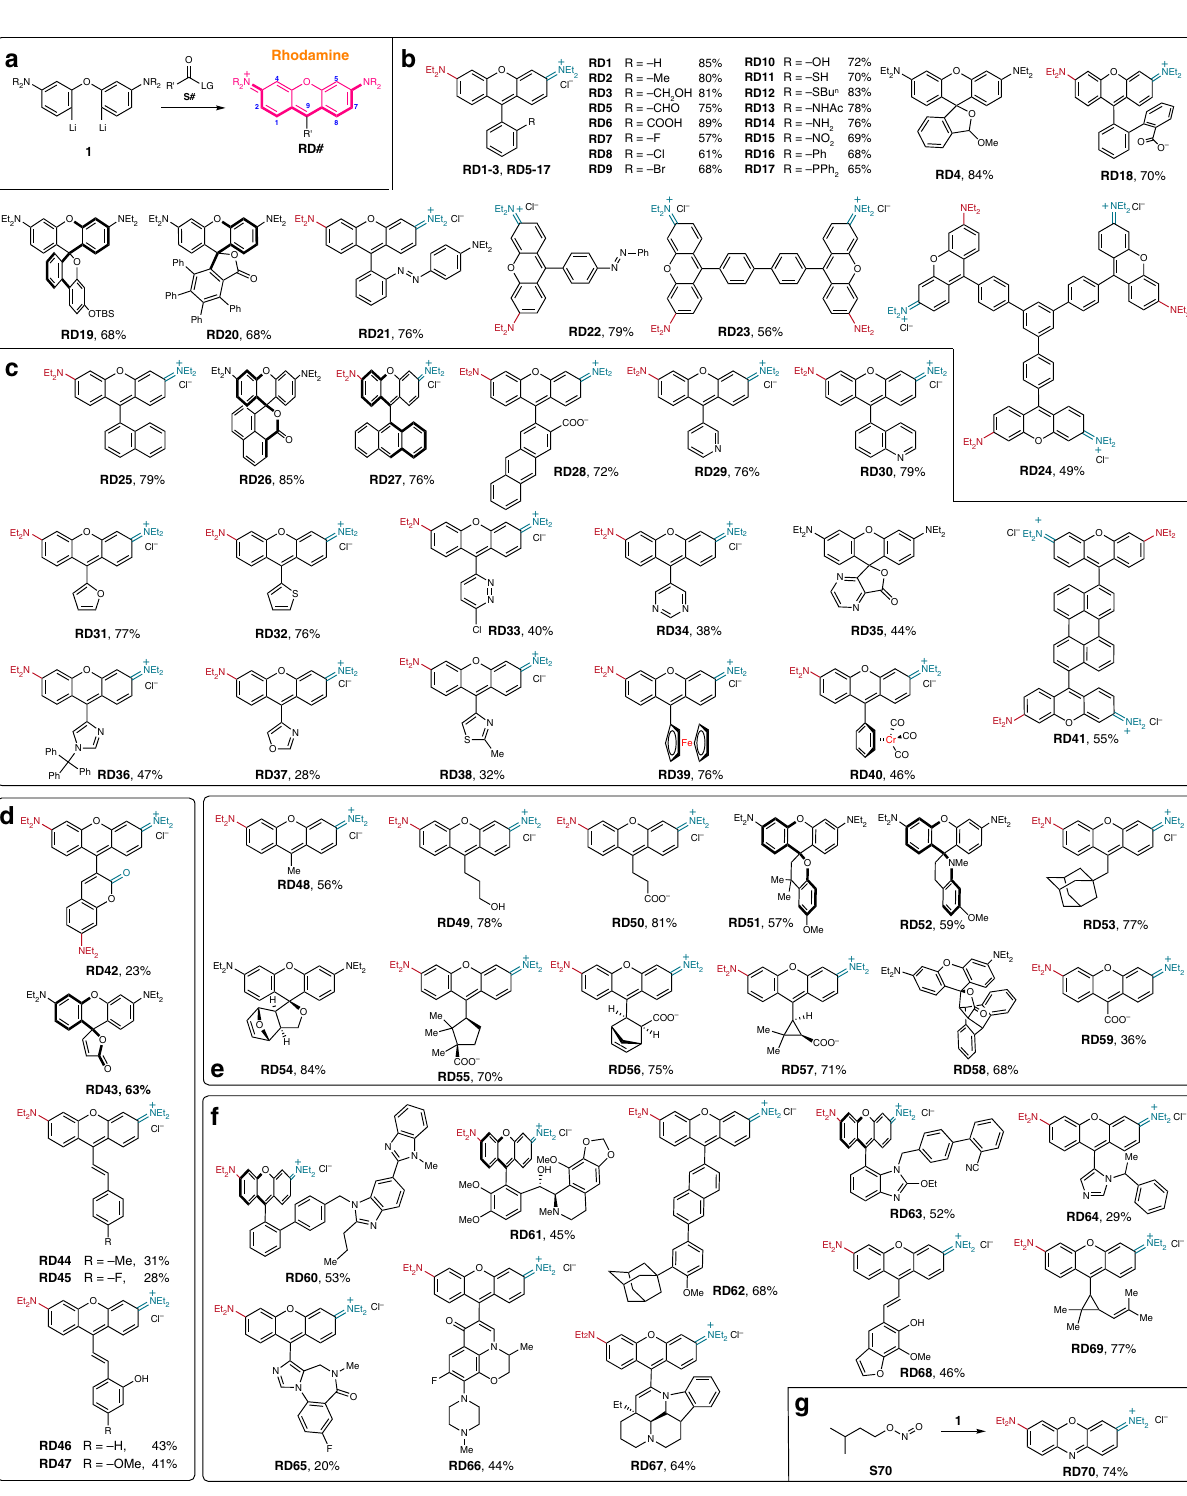
Fig. 1 The rhodamine library via nucleophilic condensation of a dilithium reagent 1 with various substrates. a The general synthetic pathway. Structures of rhodamine dyes with b phenyl groups at C-9 ( RD1 - RD24 ); c polyaromatic or heteroaryl groups at C-9 ( RD25 - RD41 ); d alkenyl groups at C-9 ( RD42 - RD47 ); e alkyl groups at C-9 ( RD48 - RD59 ); f bioactive molecules at C-9 ( RD60 - RD69 ) and g oxazine ( RD70 ). Most of the rhodamine dyes are in their chloride salt